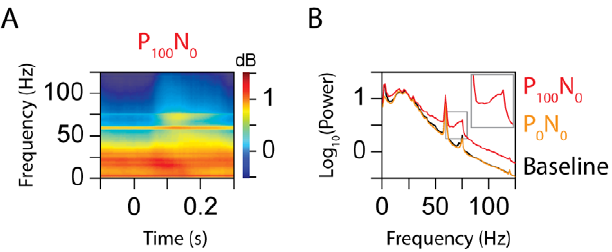
Figure 2. Time-frequency analysis. (A) Average time-frequency power spectrum of 96 sites for the P 100 N 0 condition. The sharp horizontal lines at 60 and 75 Hz reflect the increase in power due to the line noise and monitor refresh rate, respectively. (B) Left panel shows the average power spectrum (as a function of frequency) during the P 100 N 0 stimulus condition, computed by averaging the time-frequency power shown in Figure 2A between 50 and 250 ms (red trace). Spectrum for the P 0 N 0 condition (orange) and the prestimulus baseline condition (black) are also shown for comparison. The inset shows the red trace at 2 6 magnification to highlight the narrow peak due to the monitor refresh rate.